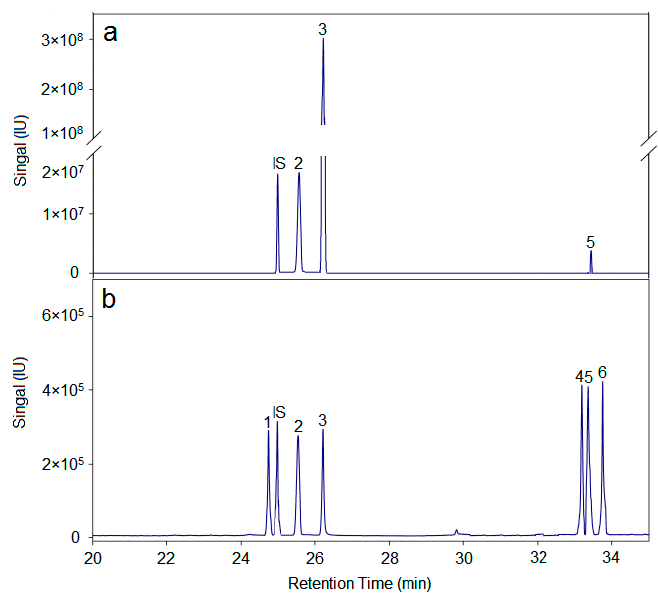
Figure 4. FT-IR spectrum of AX-I-3b.